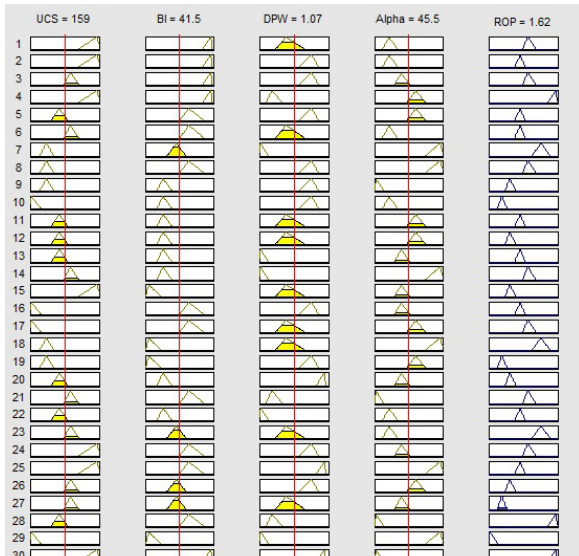
Figure 9: Fuzzy logic rules viewer.